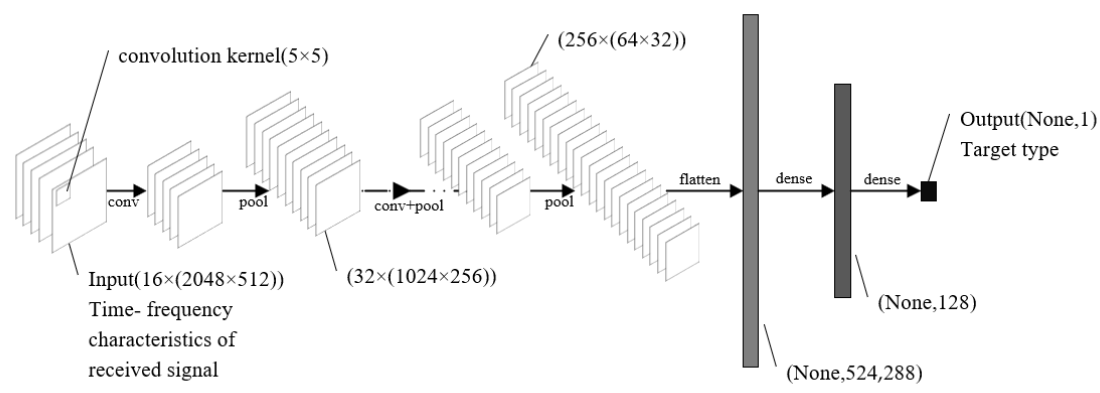
Figure 7. Network structure of the target detection model.